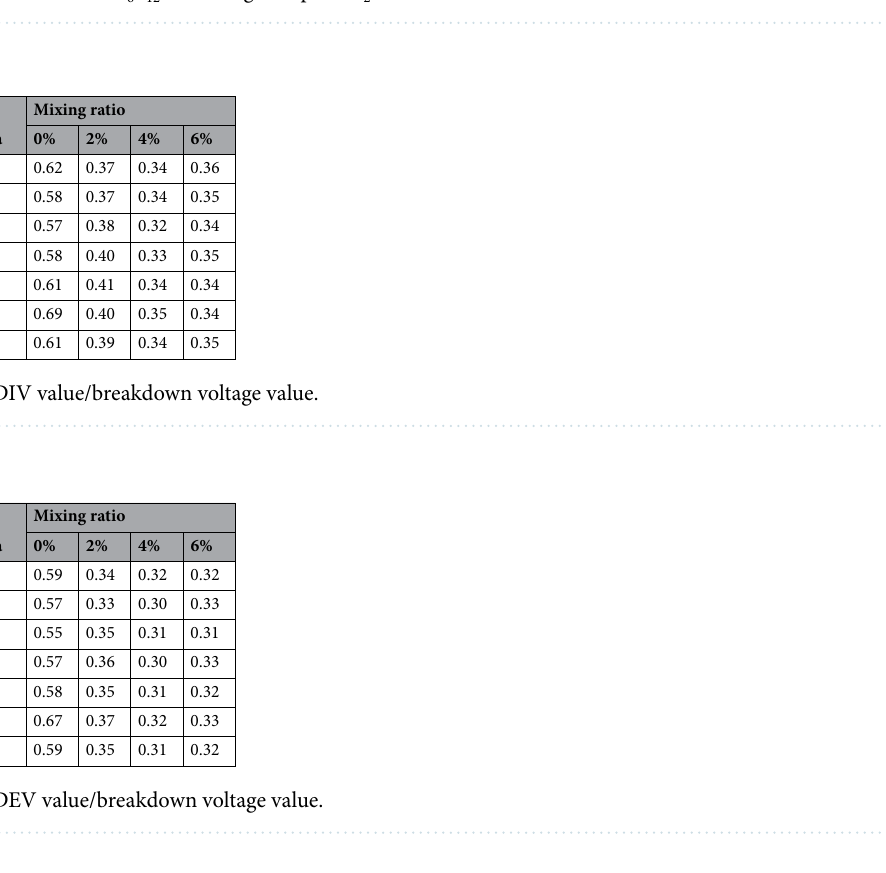
Table 3. PDEV ratio of C 6 F 12 O mixed gas to pure N 2 .